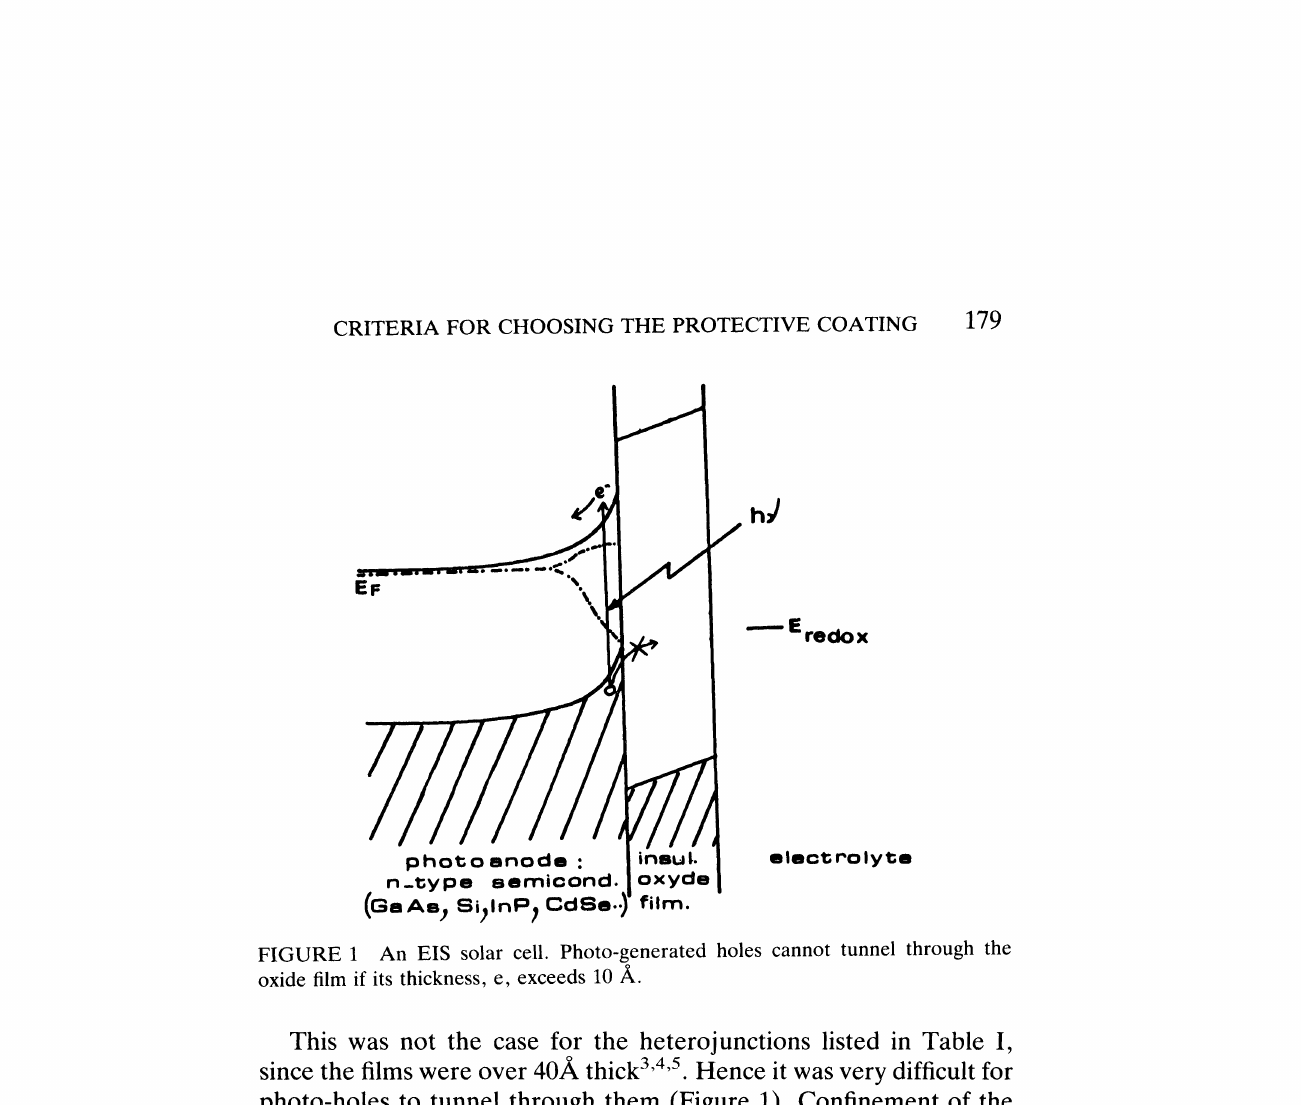
FIGURE An EIS solar cell. Photo-generated holes cannot tunnel through the oxide film if its thickness, e, exceeds 10